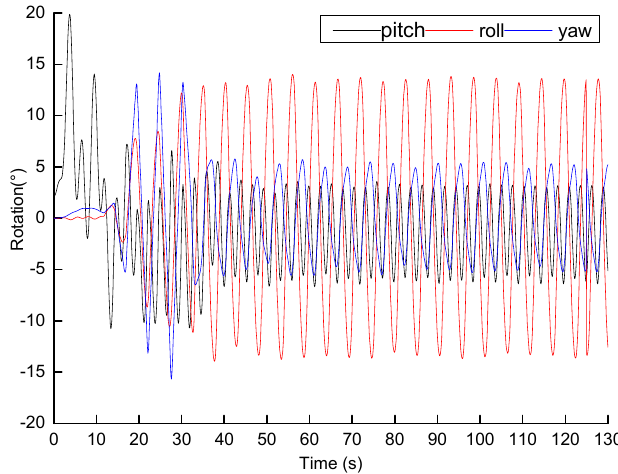
Figure 11. The angle variations of the pitch, roll, and yaw in scheme 2. The angle variations of the pitch, roll, and yaw in scheme 3 are shown in Figure 12. The pitch varies by approximately ±8°, the roll varies by ±9°, and the yaw varies by ±9°. Although the roll and yaw angles do not vary greatly, its angle variation of the pitch is